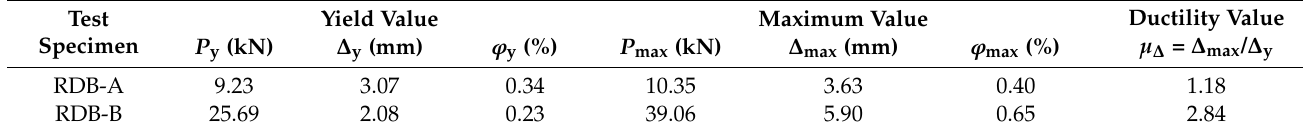
Table 2. Force, displacement and ductility results.